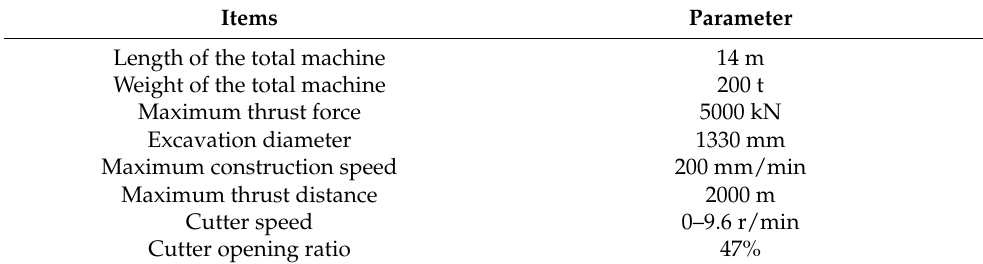
Figure 4. Driving shaft structure and installation diagram. Table 4. Specifications of the rapid laying and jacking